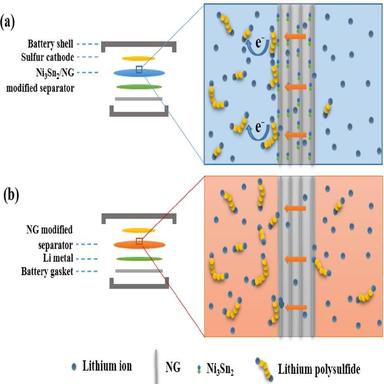
The schematic diagrams of lithium sulfur batteries with (a) Ni3Sn2/NG modified separator and (b) NG modified separator.